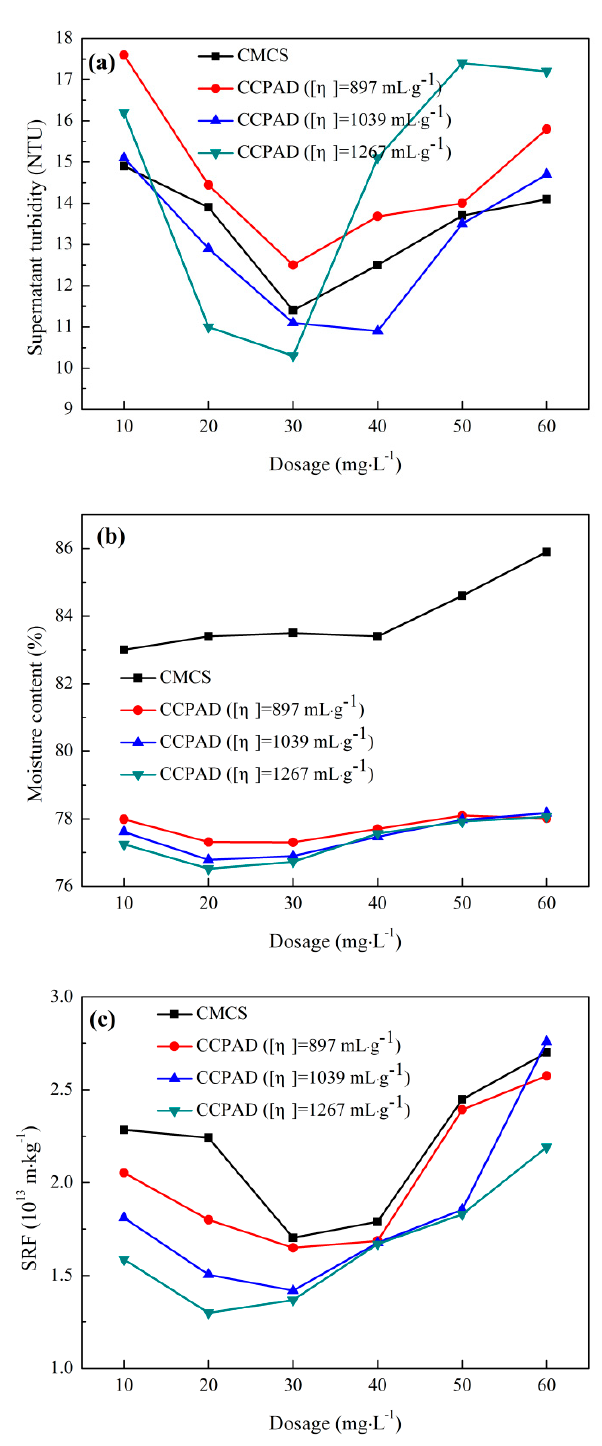
Figure 7. Effect of intrinsic viscosity on sludge dewaterability: ( a ) supernatant turbidity, ( b ) moisture content of filter cake, and ( c ) SRF.